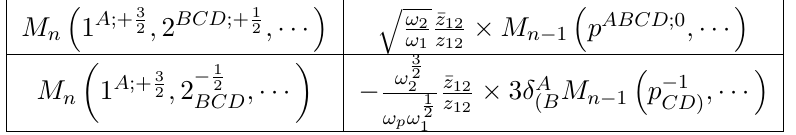
Table 11 . Amplitude corresponding to collinear gravitino and graviphotino.